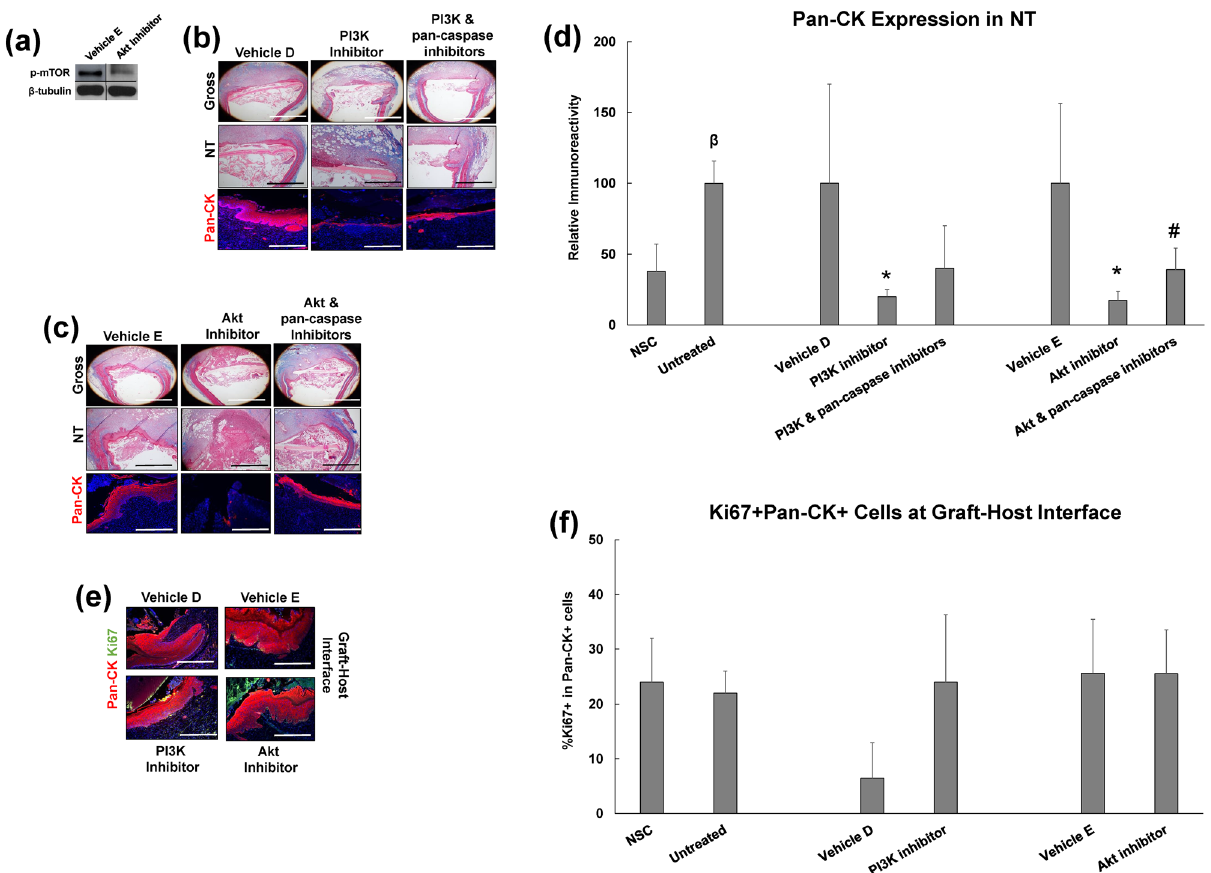
Figure 6. The role of secondary signaling messengers in constructive remodeling of esophageal tissue defects. ( a ) Immunoblot analysis of Akt target, p-mTOR and β-tubulin protein levels from neotissues treated with vehicle or Akt inhibitor for 7 days of scaffold implantation. Vehicle and inhibitor comparisons were made on the same immunoblots and with equal amounts of protein loaded per lane (N = 3–4 animals per group). Targeted bands were cropped from original full length immunoblots displayed in Supplementary Fig. S2. ( b , c ) Representative images of global and magnified esophageal cross-sections from neotissues (NT) treated with vehicles or RTK inhibitors with or without pan-caspase inhibition for 7 days post-op. Specimens were stained with Masson’s trichrome (top 2 rows in each panel) or subjected to immunohistochemical analysis for pan-cytokeratin (CK) expression (bottom row in each panel). Scale bars for top, middle, and bottom rows are respectively 1.25 mm, 500 μm, and 200 μm. ( e ) Immunohistochemical evaluations of Ki67 + pan-CK + epithelial cells at the host-graft interface in specimens described in ( b , c ). Scale bars in ( h ) for all photomicrographs are 200 μm. For ( b – h ), respective pan-CK expression is displayed in red, Ki67 expression is displayed in green and blue represents DAPI nuclear counterstain. Scale bars in ( e ) for all photomicrographs are 200 μm. For ( b , c , e ), respective pan-CK expression is displayed in red, Ki67 expression is displayed in green and blue represents DAPI nuclear counterstain. ( d,f ) Histomorphometric evaluations of pan-CK expression in NSC, untreated controls and neotissues described in ( b , c ) as well as the percentage of Ki67 + pan-CK + epithelial cells at the host- graft interface in samples described in ( e ). N = 4–8 rats per group and 2–4 sections per animal were analyzed for each data point. For panels ( d , f ), multi-group (> 3 groups) comparisons were performed with the Kruskal Wallis test in combination with the post hoc Dunn’s test. Two group comparisons were performed with the Mann–Whitney U test. (*) = p < 0.05 in comparison to respective vehicle control. (#) = p < 0.05 in comparison to respective inhibitor group. (β) = p < 0.05 in comparison to NSC. Data are expressed as means ± standard